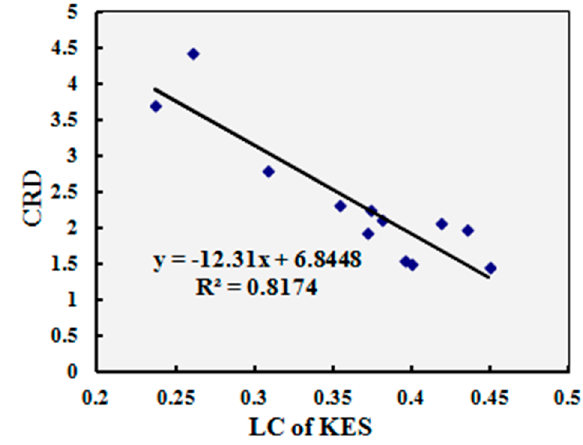
Figure 12. Relationship between compression rigidity descending (CRD) and LC of the Kawabata Evaluation System (KES) system, LC: linearity of compression.